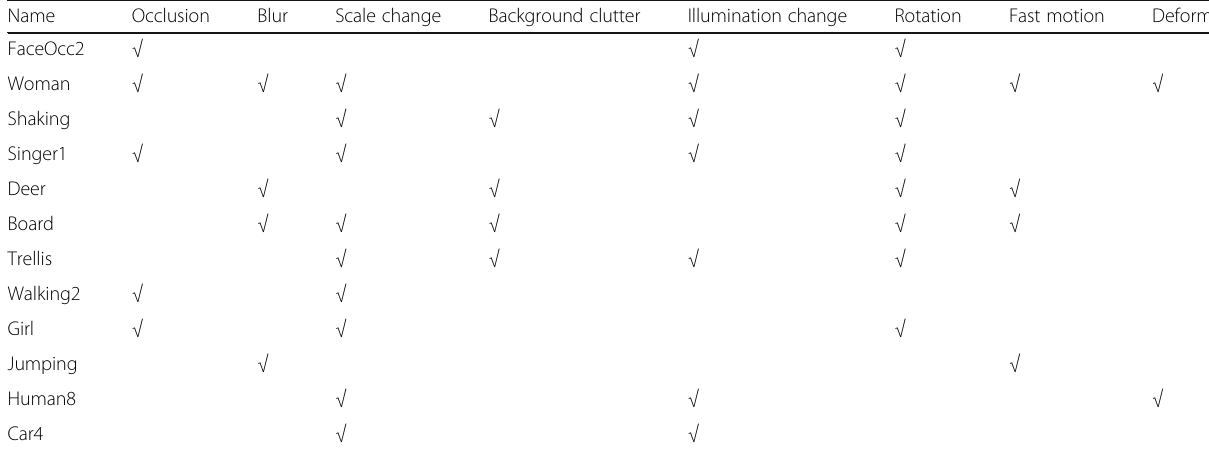
Table 1 The features of the video